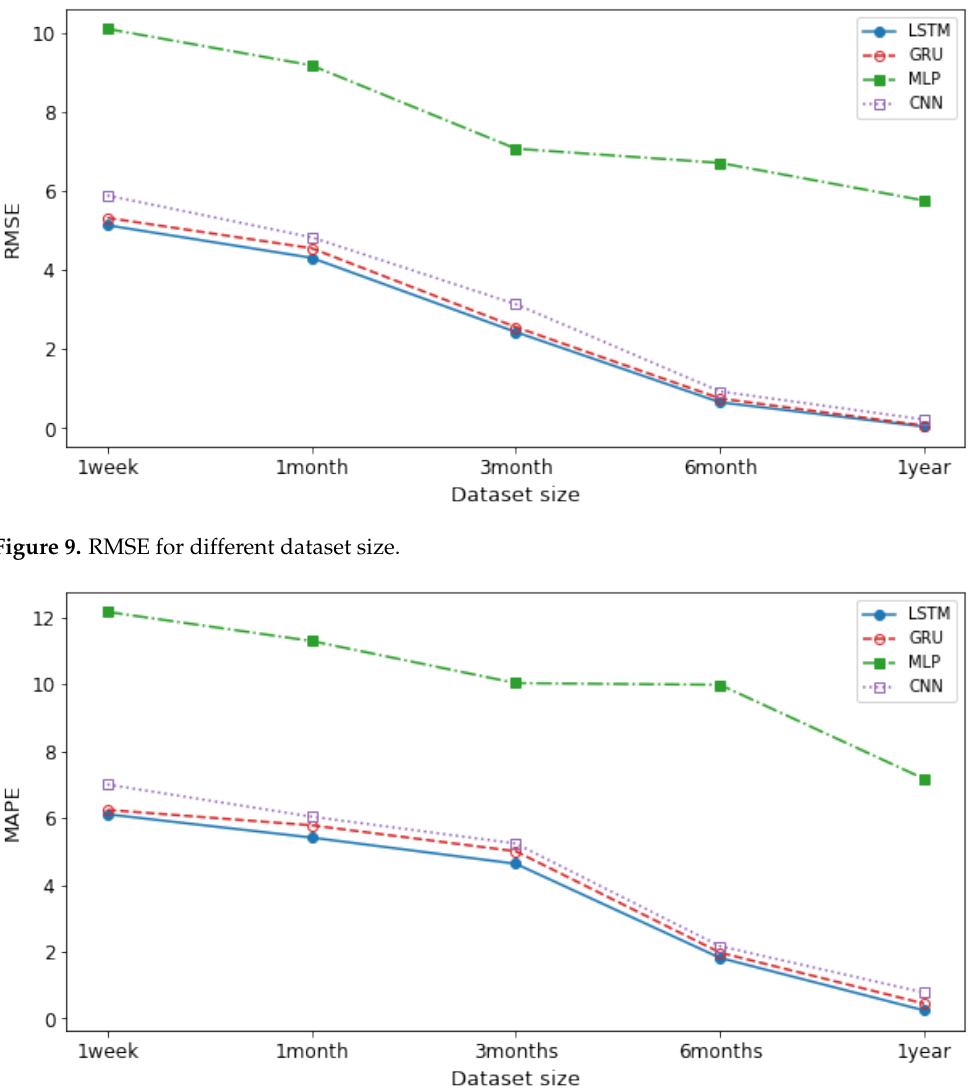
Figure 10. MAPE for different dataset